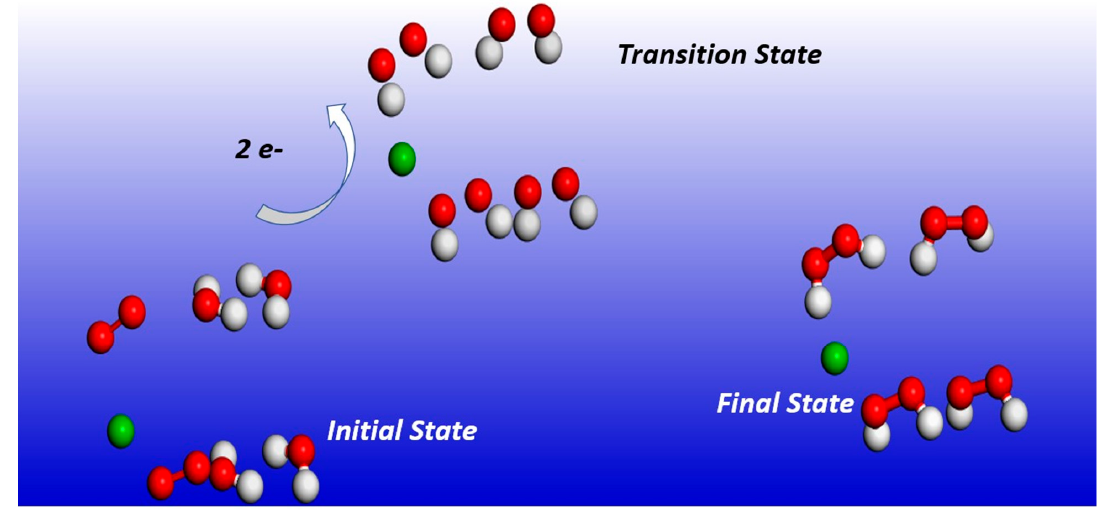
Figure 4. Doubly-charged anionic transition state geometry optimization for Sn. The red, white and green spheres represent O 2 , H 2 and Sn (catalyst), respectively. Note the broken bonds in the transition state.